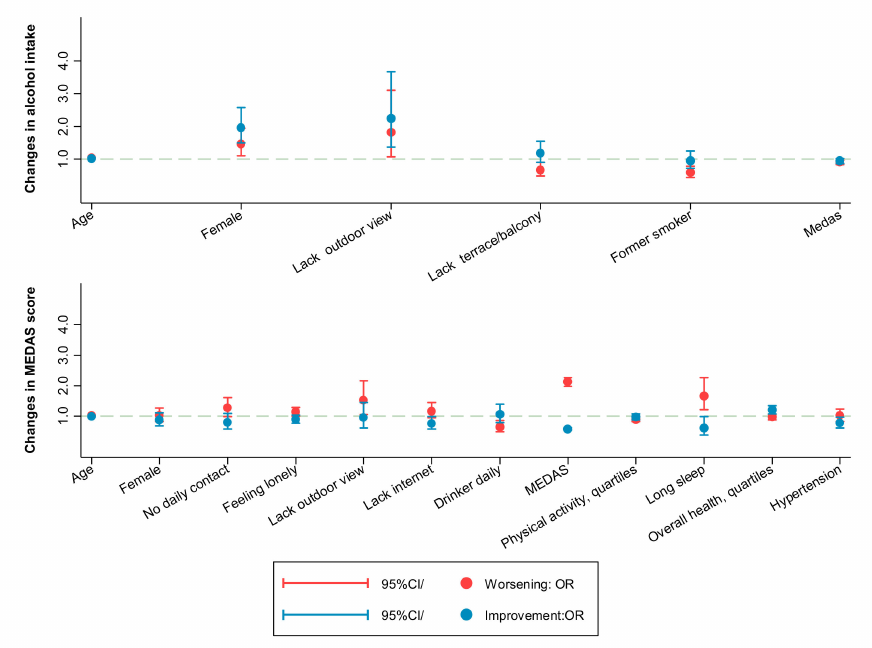
Figure 2. Prospective association between baseline participant characteristics and changes in al- cohol consumption or in adherence to the Mediterranean diet adherence screener (MEDAS) score during